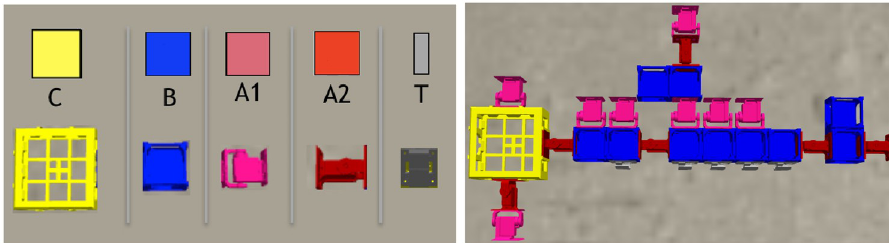
Fig 1. On the left, the robot modules: Core-component with controller board (C). Which is the head of the robot; Structural brick (B); Active hinges with servo motor joints in the vertical (A1) and horizontal (A2) axes; and Touch sensor (T). Modules C and B have attachment slots on their four lateral faces, and A1 and A2 have slots on their two opposite lateral faces; T has a single slot which can be attached to any slot of C or B. On the right, an example of simulated